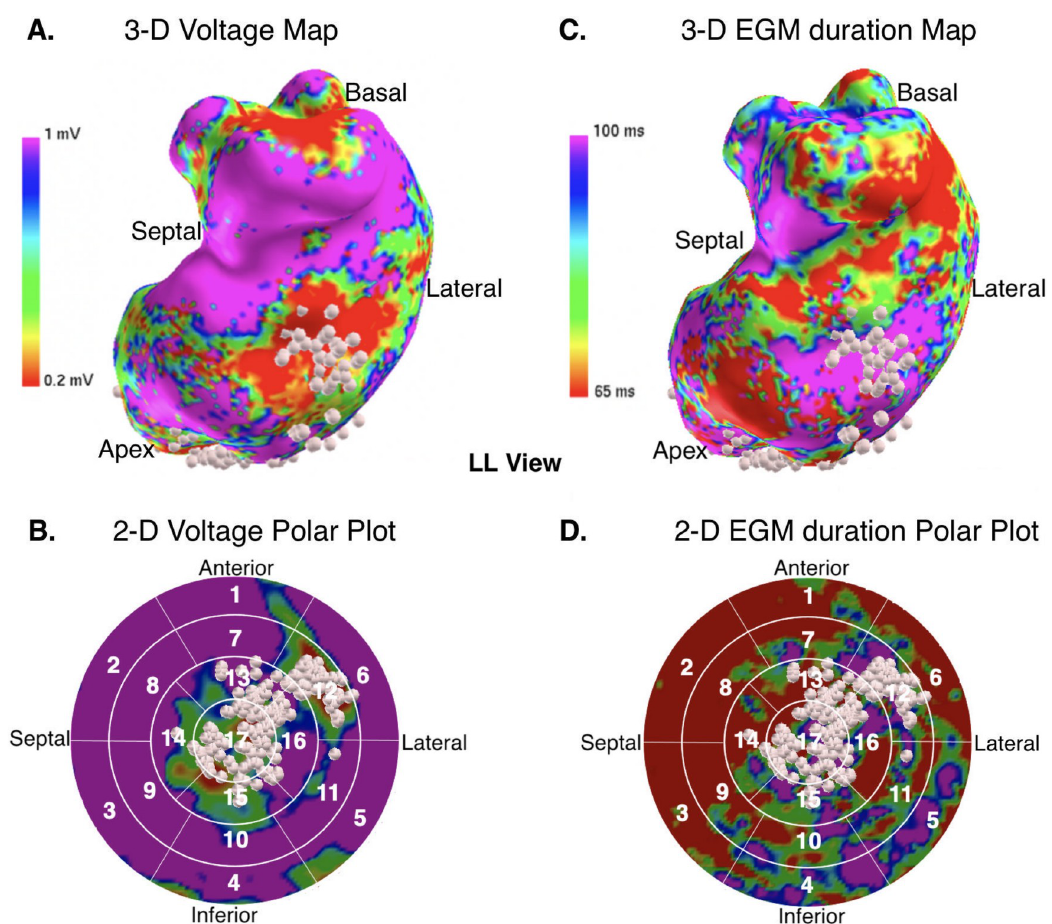
Fig 5. Image integration of a left ventricular 3-D-electroanatomical voltage and electrogram duration map into the 17-segment model. (A) Left ventricular 3-dimensional voltage map (left) and 3-dimensional electrogram (EGM) duration map (right) in a patient with scar-related ventricular tachycardia during sinus rhythm demonstrating that majority of ablation points (white points) were performed in areas with dense scar (red), scar border zone (yellow, green and blue) and long EGM duration (purple). The clinical documented VT was induced (cycle length: 320 ms) and terminated by ablation. (B) Electro-anatomical 2-dimensional polar plot translation of voltage map (left) and electrogram duration map (right) demonstrating the feasibility